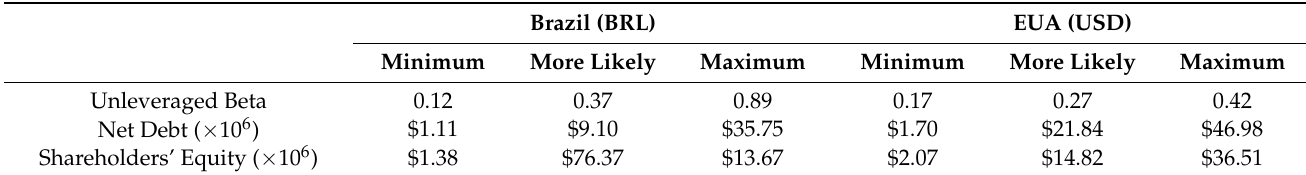
Table 4. Maximum, minimum and most likely values of the thermoelectric plant capital cost variables for estimating the